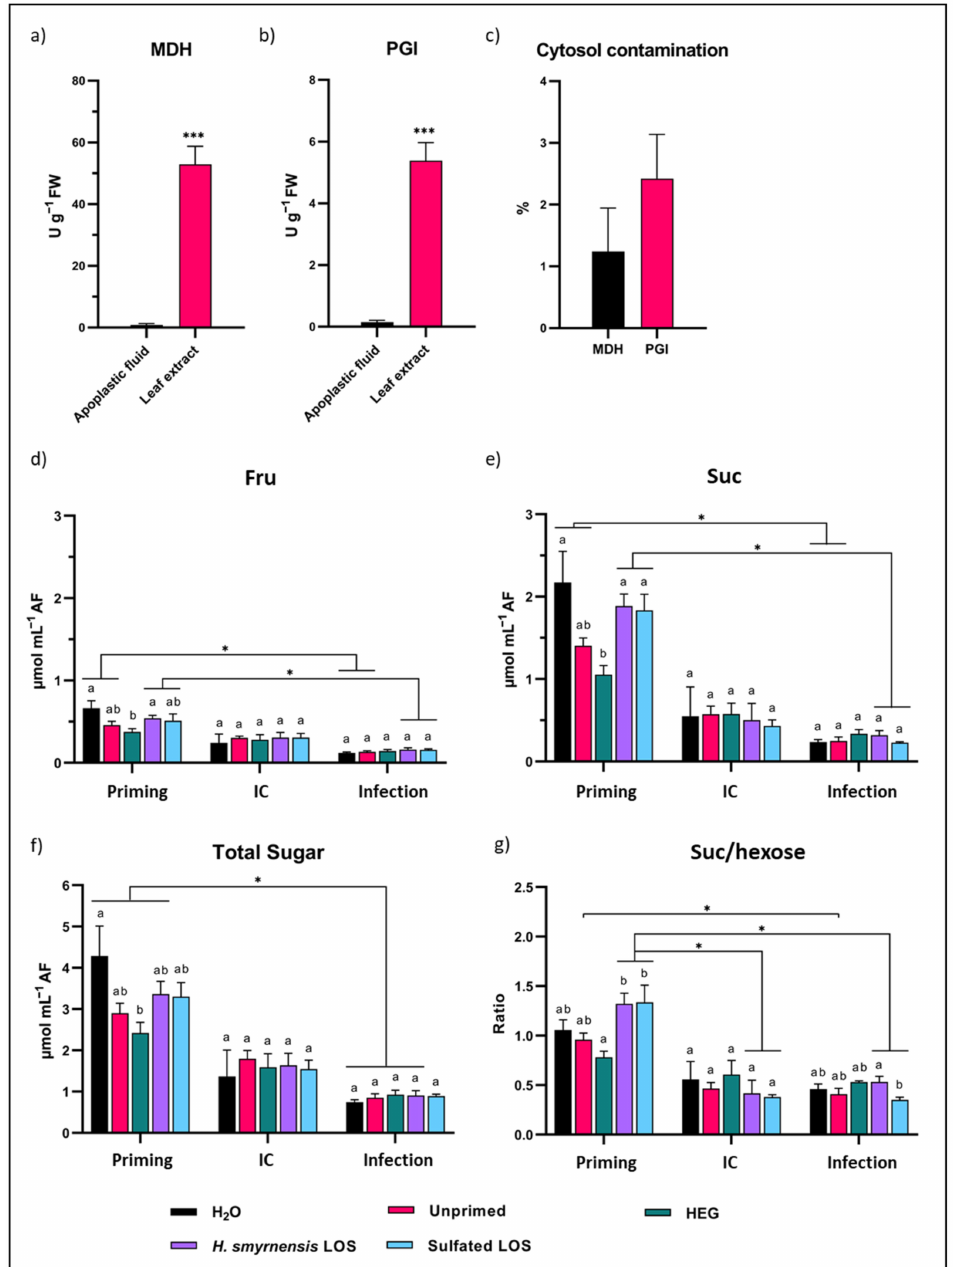
Figure 8. Measuring apoplastic sugars after fructan priming in the rocket- Botrytis cinerea pathosys- tem with low cytosol contamination rates. Apoplastic fluid (AF) was extracted through vacuum infiltration-centrifugation techniques. Cytosol contamination was tested by comparing activity of ( a ) malate dehydrogenase (MDH) and ( b ) phosphoglucoisomerase (PGI) activity of AF and full leaf extracts. ( c ) Cytosol contamination levels were calculated as the percentage activity in AF compared to full leaf. Levels of ( d ) fructose (Fru) and ( e ) sucrose (Suc) were measured from AF samples on HPAEC-IPAD and ( f ) total sugar and ( g ) Suc/hexose ratio were calculated. Samples were taken from primed or infected leaves. Infection control (IC) samples were also included. Bars represent the mean ± SEM. At least 6 biological replicates were used per treatment. The cytosol contamination assay was repeated 3 times with consistent results. Letters indicate significant differences between treatments within the same time point ( p < 0.05). Asterisks indicate significant differences of the same treatment between time points or between extraction methods (* p < 0.05; *** p <